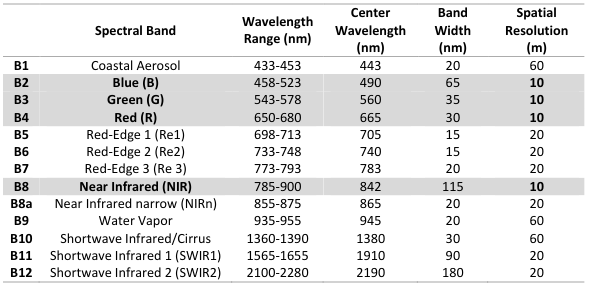
Figure 1. Main spectral bands specifications for Sentinel-2 MSI Data acquired by MSI instrument are systematically processed to Level-1C, which provides orthorectified Top-Of-Atmosphere (TOA) reflectance, with sub-pixel multispectral registration. Then, all images have been processed in SNAP, using the Sen2Cor tool, which performs atmospheric-, terrain and cirrus correction, of TOA Level 1C data, to get Level-2A Bottom-Of- Atmosphere (BOA) reflectance processed images.